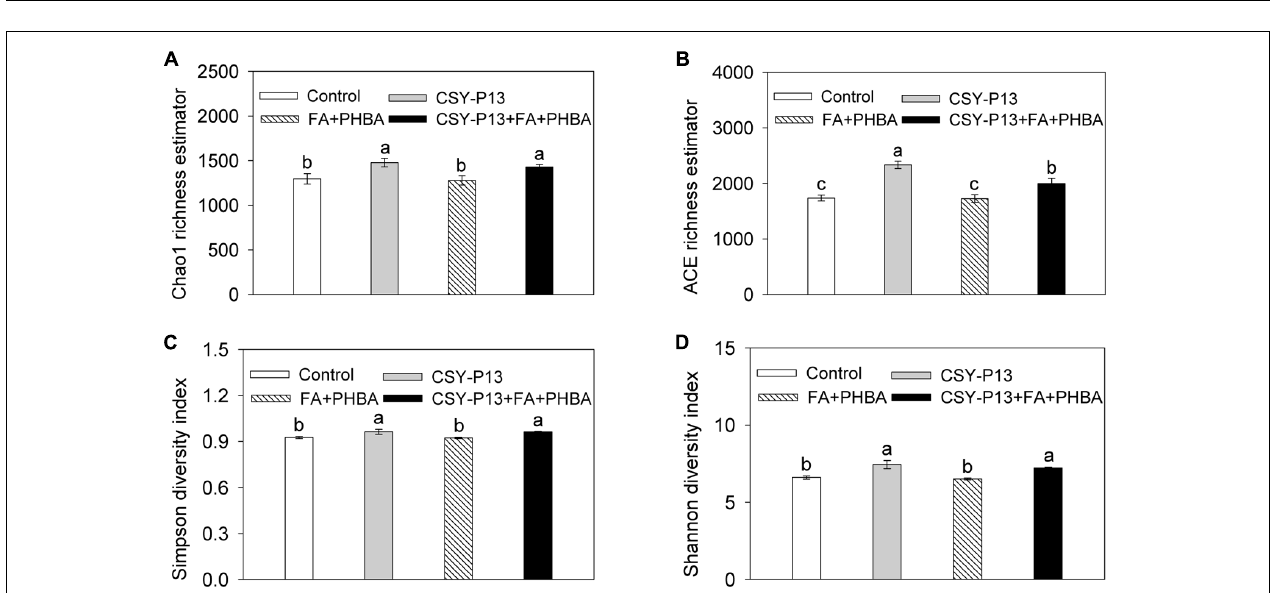
FIGURE 7 | Effects of CSY-P13 and the mixture of FA and PHBA on phosphatase (A) , CAT (B) , urease (C) , and sucrase (D) activities in cucumber rhizospheric soil. Bars represent standard errors of three biological replicates. Values with the different letters are significantly different at P < 0.05 by LSD test using SPSS for Windows 22.0 software (IBM Corp., Armonk, NY, United States).